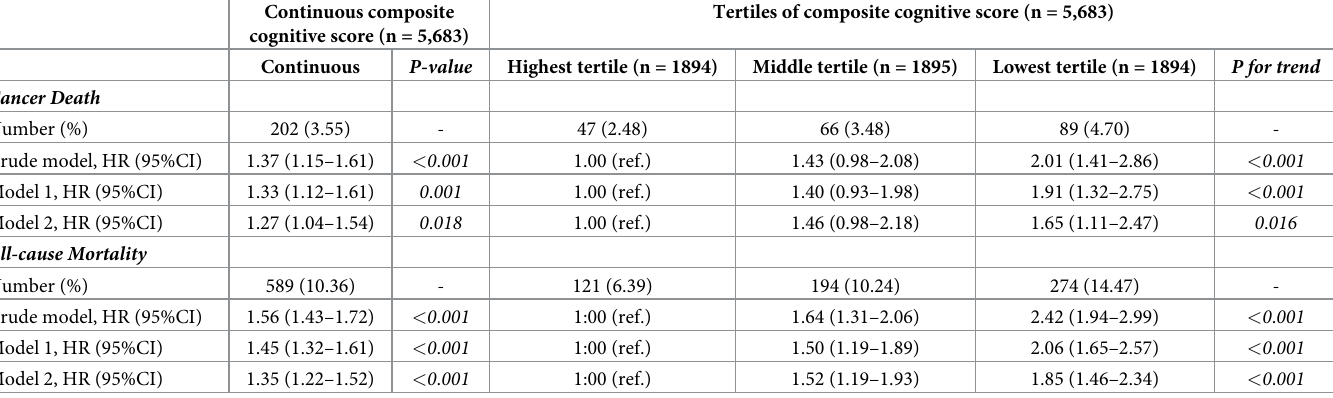
Table 2. Risk of cancer death and all-cause mortality in relation to tertiles of composite cognitive score of PROSPER. Continuous composite cognitive score (n = 5,683)